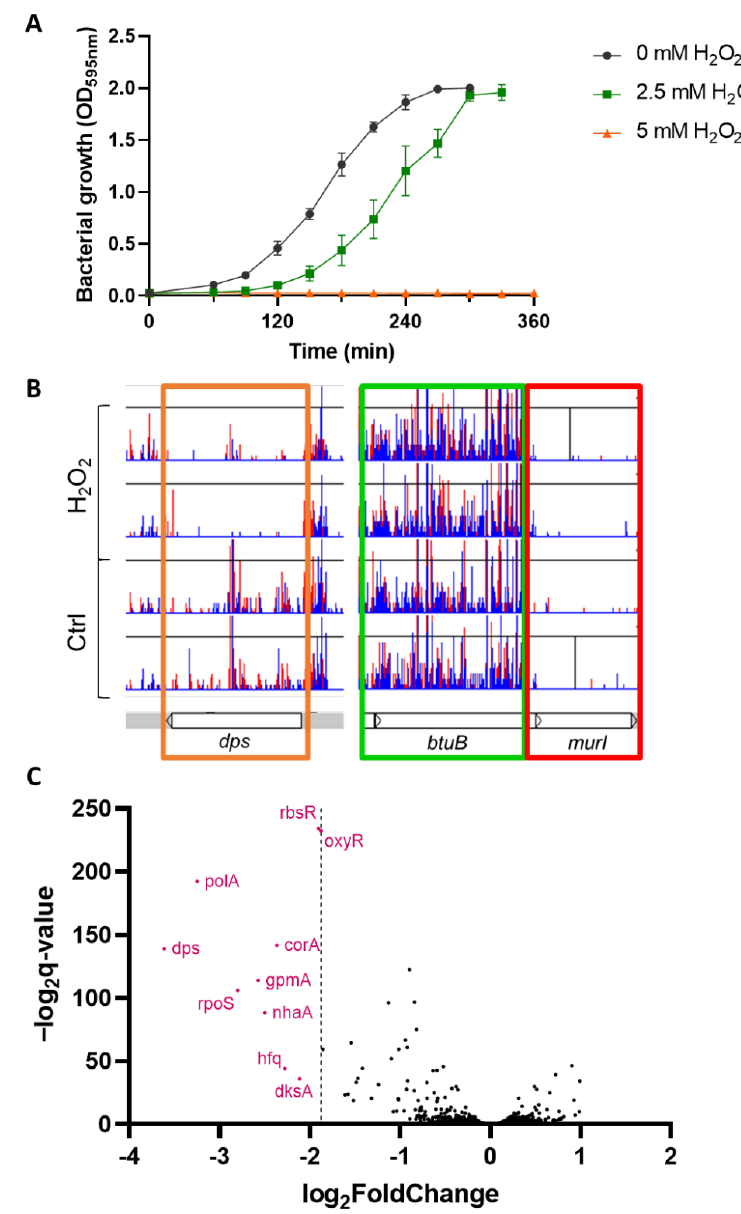
Figure 1. Transposon-directed insertion sequencing (TraDIS) screen of E.coli BW25113 under sublethal concentration of H 2 O 2 ( A ) Bacterial growth of E. coli BW25113 over time with 2.5, 5 mM H 2 O 2 and untreated control. The concentration of 2.5 mM was chosen for TraDIS experiment as it displayed a high reproducibility and a delay of approximatively 70 min compared to control (mean +/ − SD, N = 3); ( B ) Visualization of the TraDIS data using Artemis where each sample is represented by a histogram depicting the localization (X-axis) and the frequency (Y-axis) of transposon insertion sites (in red are antisense insertions, in blue are same sense insertions). Representative examples of essential gene ( murI in red box), non-essential genes ( btuB , in green box) and genes with a reduced fitness in the H 2 O 2 condition ( dps in orange box), ( N = 2) ( C ) Fitness analysis of the TraDIS data, H 2 O 2 -treated condition compared to control. Each dot represents a gene, X-axis represents the difference in number of insertions in the H 2 O 2 condition compared to control, Y-axis represents the statistical significance. Nine genes (in pink) displayed a significant and more extreme change than the H 2 O 2 -sensor gene oxyR .